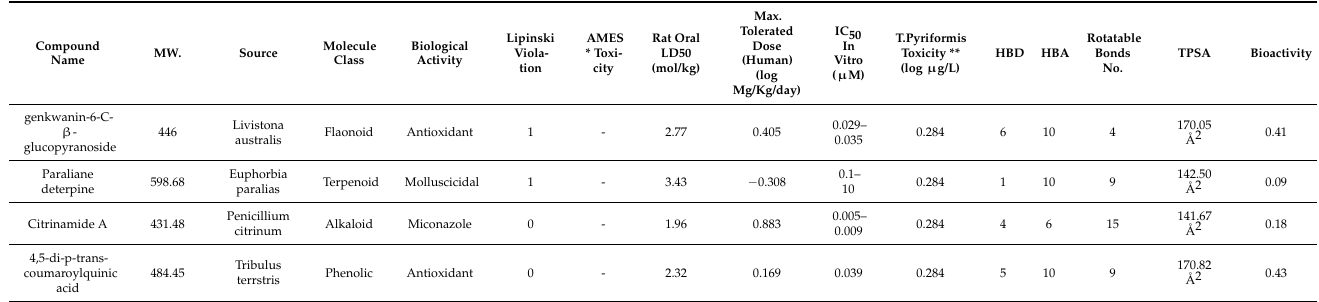
Table 2. ADMET analysis, biological and toxicology